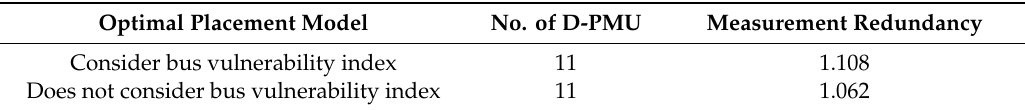
Table 2. E ff ect of bus vulnerability index on placement results. Table 2. Effect of bus vulnerability index on placement results.